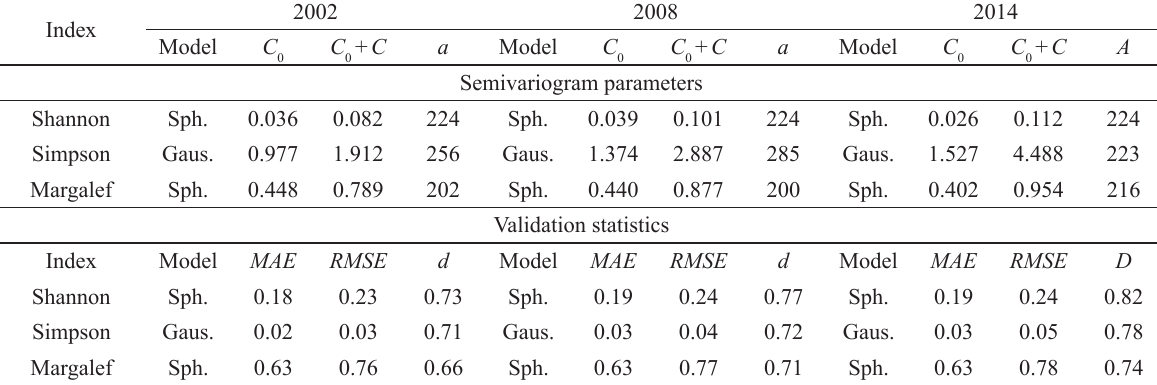
Semivariogram parameters and validation statistics of diversity indices in a mixed tropical forest